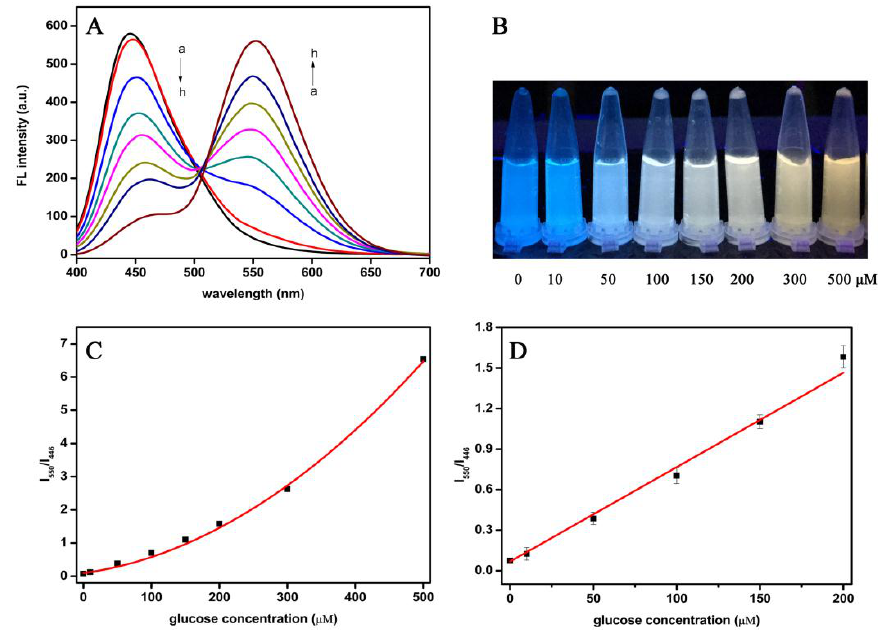
Figure 4. ( A ) The fluorescence spectra for detecting glucose with different concentrations (a → h, the final glucose concentrations are 0, 10, 50, 100, 150, 200, 300, 500 μM, respectively) using the dual-mode sensor. ( B ) The colors of glucose detection solutions at different concentrations under the ultraviolet light of 365 nm. ( C ) The relationship curve between the fluorescence ratios of oxODB to CQDs (F 550 /F 446 ) and glucose concentrations between 0 and 500 μM. ( D ) The linear relationship between I 550 /I 446 and glucose concentrations ranging from 0 to 200 μM.